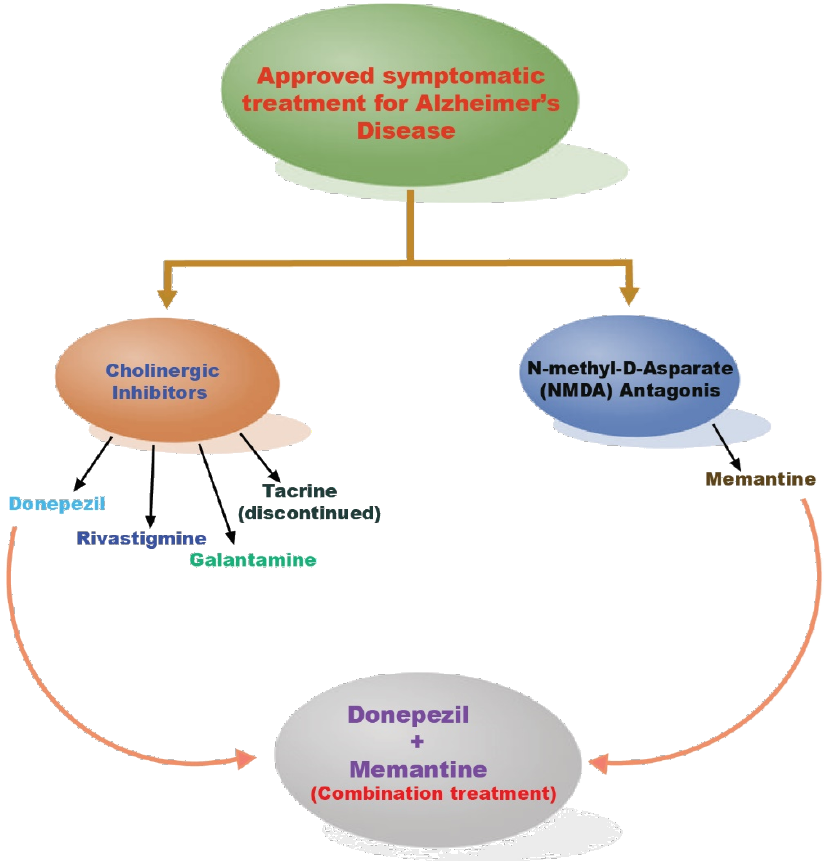
Figure 7. AChE inhibitors for the treatment of AD along with NDMA antagonist memantine.